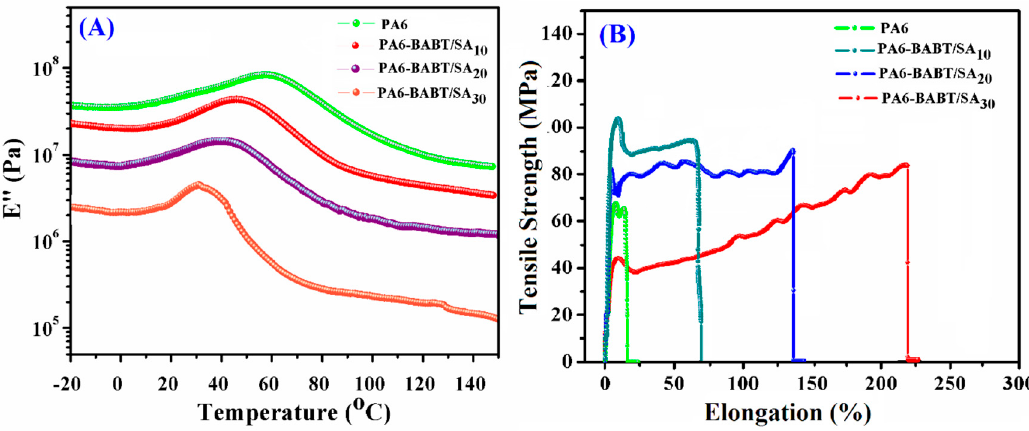
Figure 15. ( A ) DMA curves (loss modulus E”) of PA6 and PA6-BABA/SA copolyamides. ( B ) Tensile strength curves of PA6 and PA6-BABA/SA copolyamides.